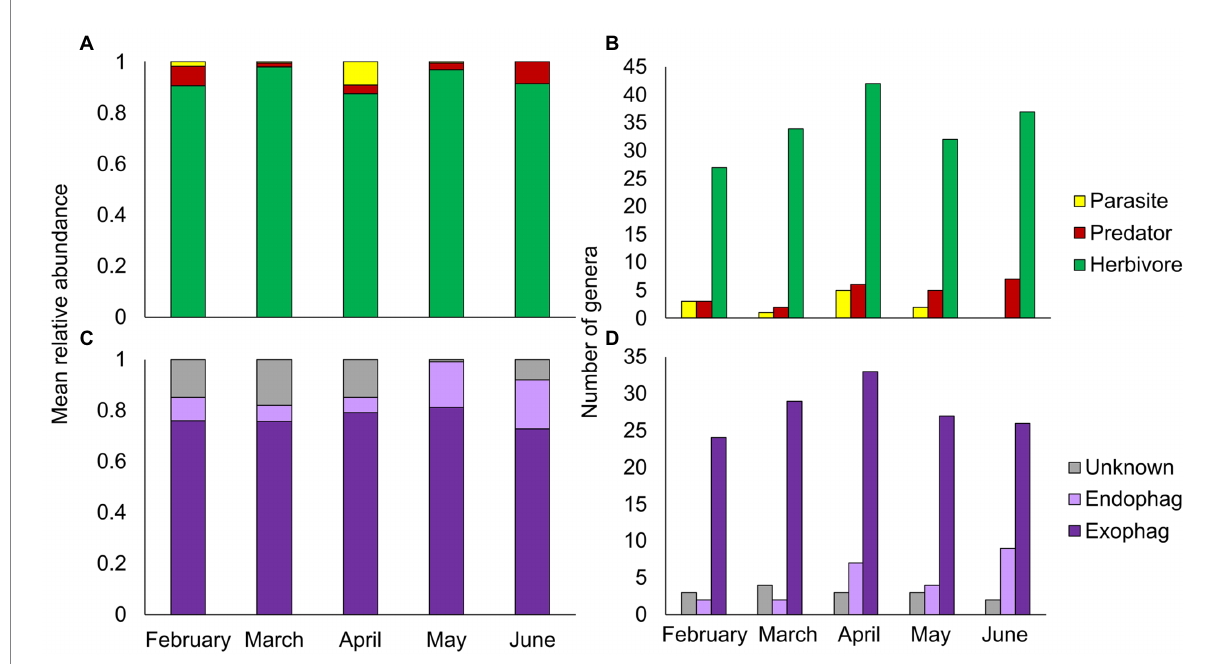
FIGURE 3 Composition of plant-dwelling arthropods ingested by goats across five sampling months (February–June). (A,B) Mean relative abundance and number of genera of herbivore, predator and parasitic arthropods. (C,D) Mean relative abundance and number of genera of herbivorous arthropods by feeding niche (exophages – feed on the plant surface; endophages – feed within plant parts).